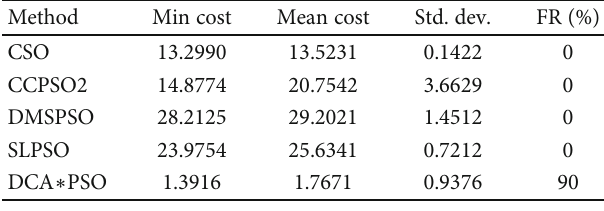
Table 3: The statistical results of two cases.